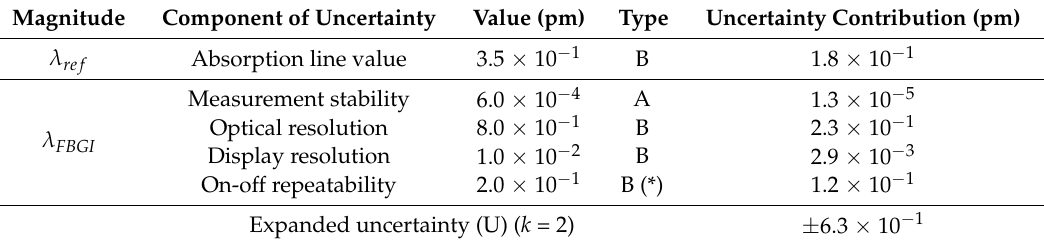
Table 4. Calculation of uncertainties of the second method experimental setup at λ WM ≈ 1530 nm and for a period of time of 30 min, corresponding to n =